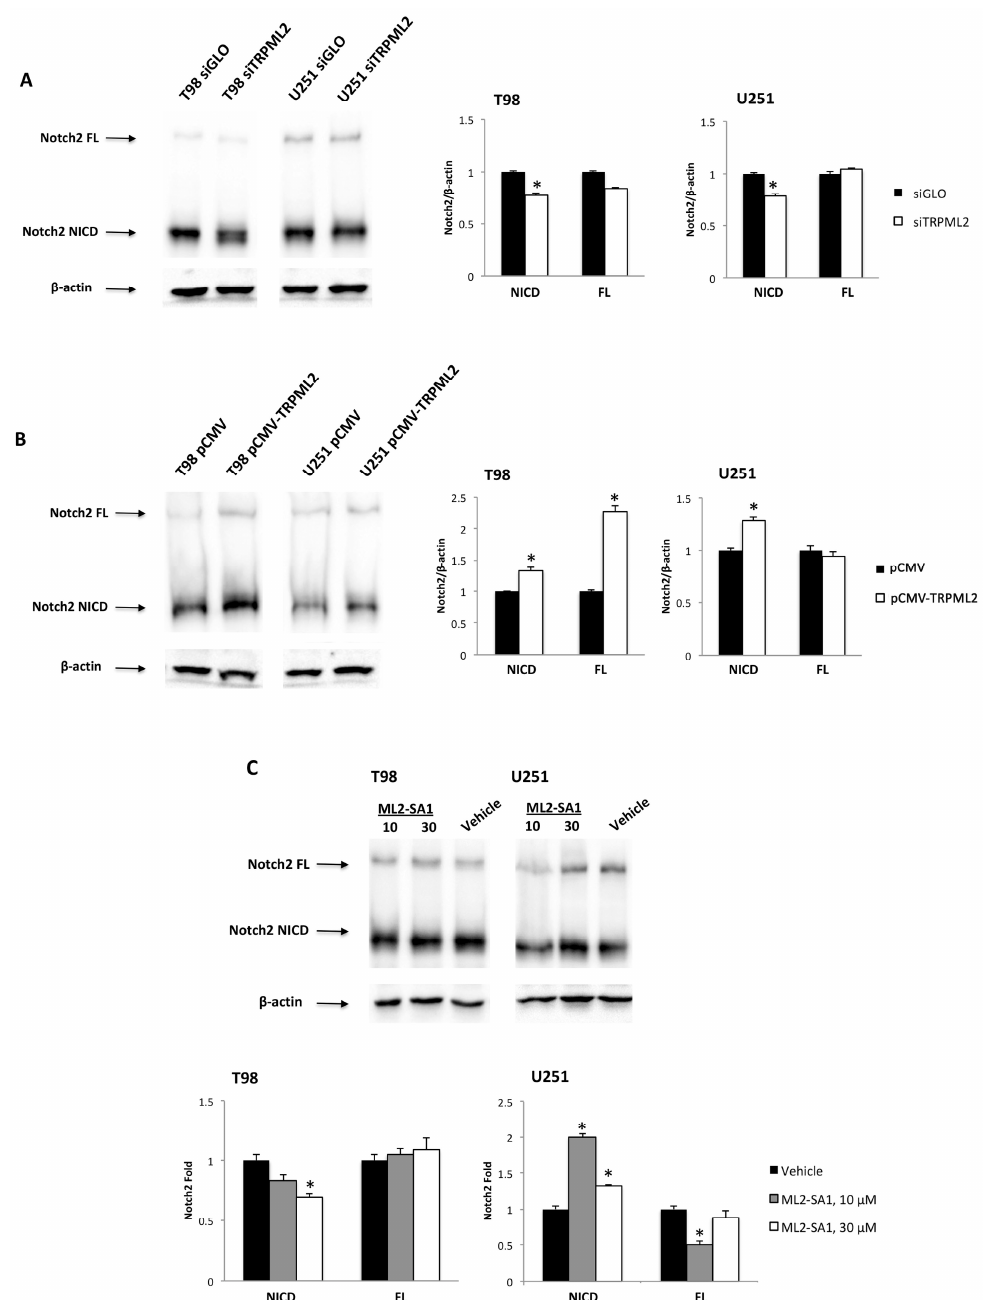
Figure 3. Expression of Notch2 protein in TRPML2 silenced or overexpressed and ML2-SA1 treated cell lines. Representative immunoblots reflecting Notch2 FL (full-length) and NICD (Notch intracellular domain) protein levels in siGLO and siTRPML2. ( A ) and in pCMV and pCMV-TRPML2. ( B ) T98 and U251 cell lines after 48 h post-transfection. ( C ) The Western blot analysis of Notch2 protein levels in T98 and U251 cell lines treated with vehicle or ML2-SA1 (10 and 30 μ M) for 24 h. Blots are representative of one of three separate experiments. Densitometry values were normalized to β -actin, which was used as a loading control. Data are expressed as the mean ± SE of three separate experiments. * p < 0.05 siTRPML2 vs. siGLO cells, pCMV-TRPML2 vs. pCMV and ML2-SA1 vs.